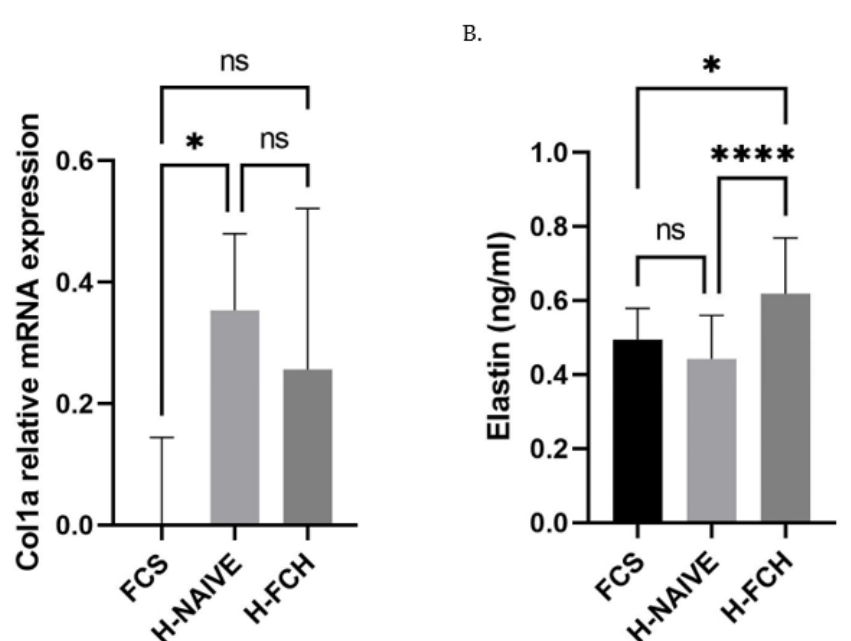
Figure 5. Primary human dermal fibroblasts (adult) were incubated in the presence of either fetal calf serum or human naive serum (H-NAIVE) or human serum enriched with metabolites deriving from FCH ingestion (H-FCH). Collagen 1a mRNA expression ( A ) and elastin protein concentration ( B ). Measures were performed in quadruplicates per condition/volunteer ( n = 10 volunteers). Values are presented as the means ± SD. The differences were considered statistically significant at p < 0.05 with * for p < 0.05; **** for p < 0.0001 and ns for p >